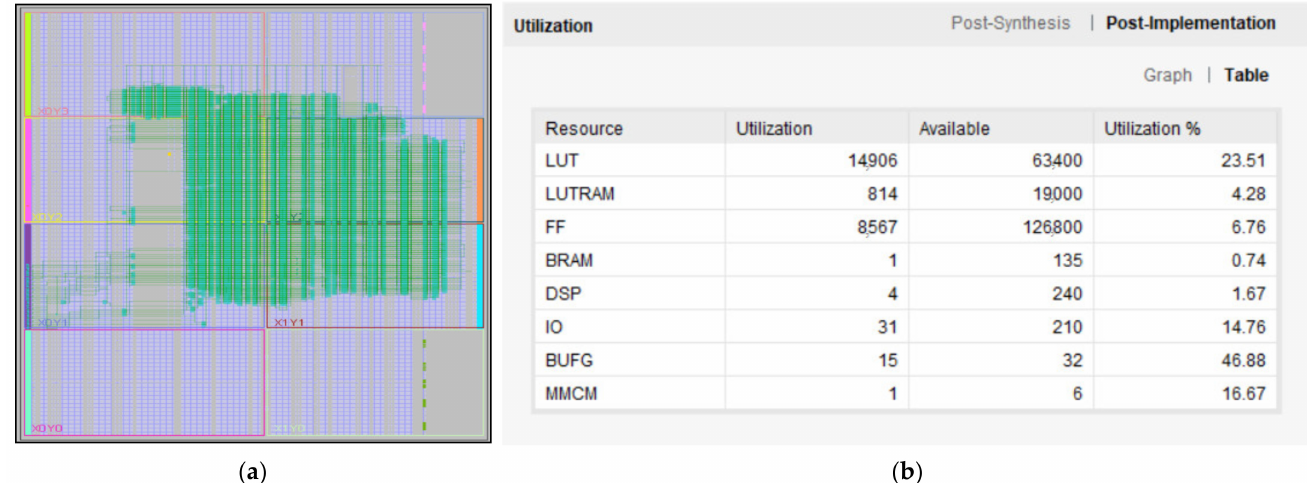
Figure 8. ( a ) Distribution of the HW_RTOS_nMPRA (4sCPUi) project logic components, including the preemptive scheduler on the Nexys 4 DDR; ( b ) post-implementation FPGA resource requirements for nMPRA + nHSE (Artix-7 FPGA chip